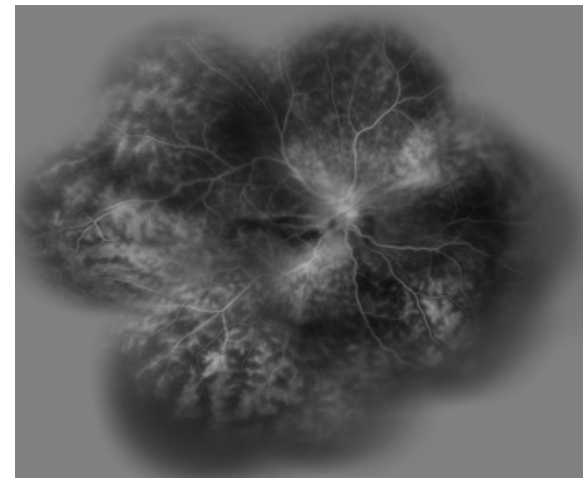
Figure 2: Fluorescein angiogram of the right eye showed diffuse hyper fluorescence which correspondedto telangectatic vessels with leakage